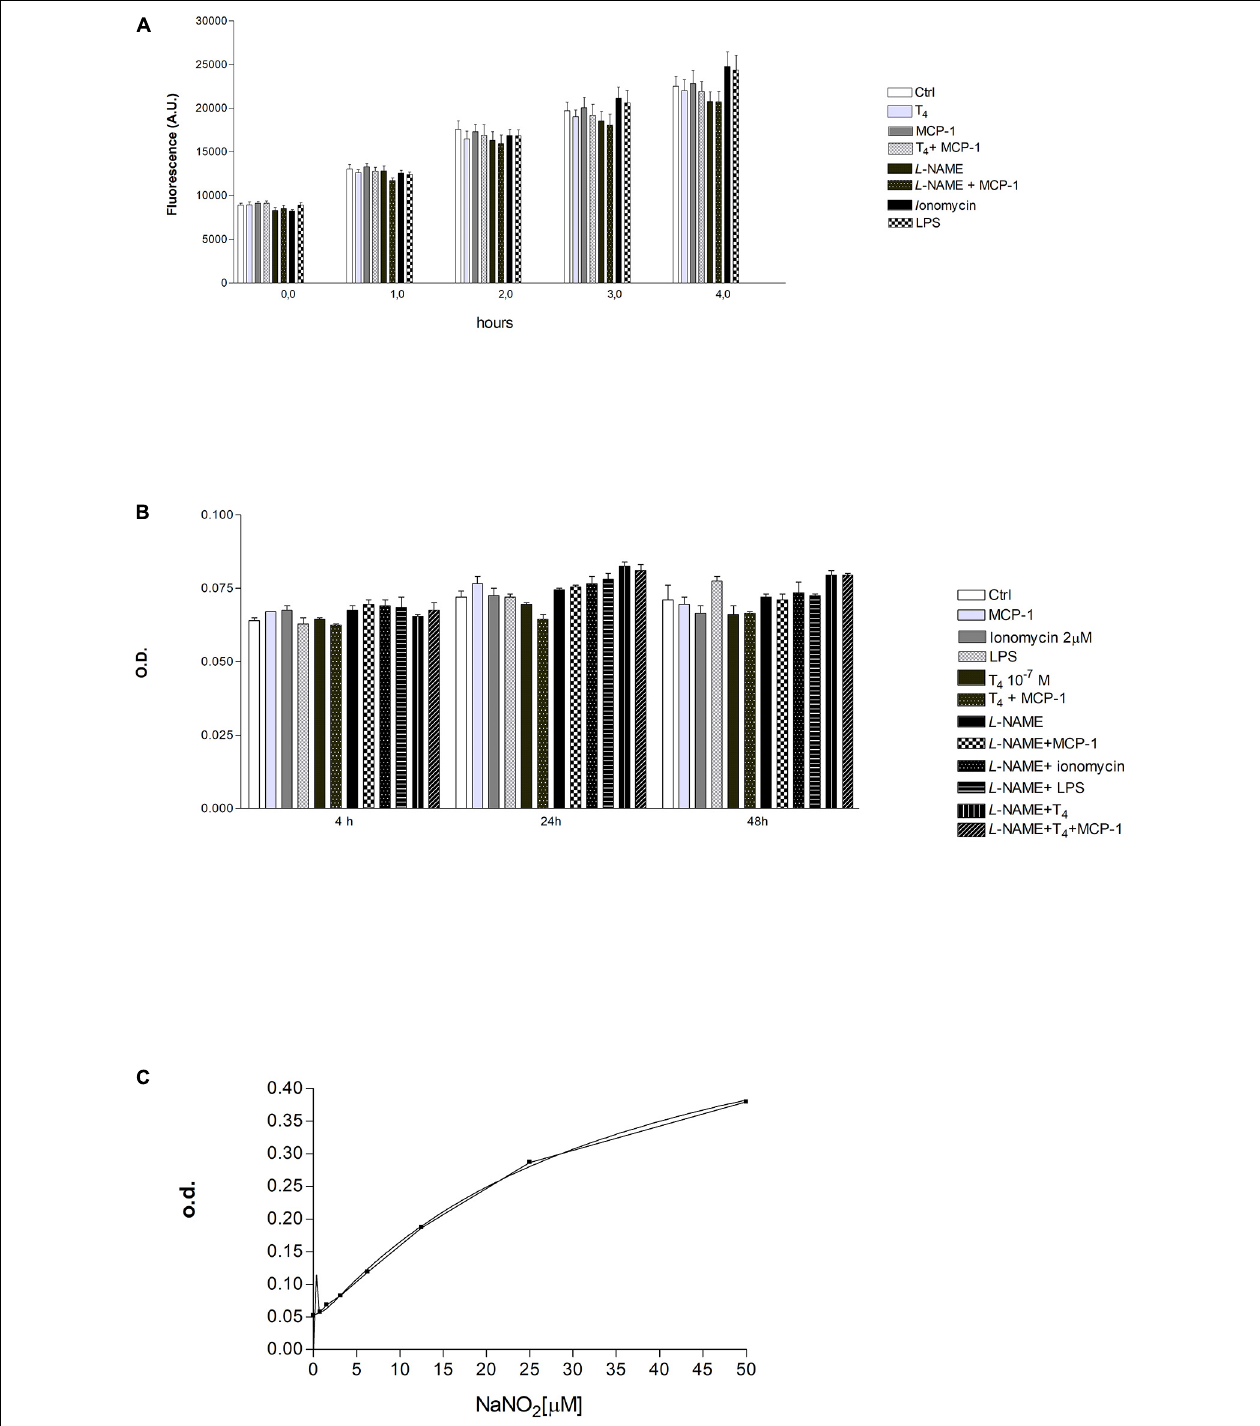
FIGURE 8 | (A) Effect of T 4 (10 − 7 M) and monocyte chemoattractant protein 1 (MCP-1) (100 ng/ml) on reactive nitrogen species (RNS) production in THP-1 monocytes. N ω -nitro- L -arginine methyl ester hydrochloride ( L -NAME; 1 mM), ionomycin (2 µ M), lipopolysaccharide (LPS; 1 µ g/ml). Results are reported as mean ± SD of n = 3 different experiments. None of the differences was significant within the same time frame. (B) Measurements of optical density (OD) by ELISA reader, after 4, 24, and 48 h of stimulation with T4 (10 − 7 M), MCP-1 (100 ng/ml), L -NAME (1 mM), ionomycin (2 µ M), and LPS (0.1 µ g/ml). Results are reported as mean ± SD of n = 3 different experiments. None of the reported differences was significant. (C) Concentration of nitrite in the supernatants of samples of Figure 7B was extrapolated using a calibration curve based on the known concentrations of sodium nitrite (NaNO 2 ; 0–50 µ M) reacted with the Griess reagent. The graph shows two calibration curves carried out for two different